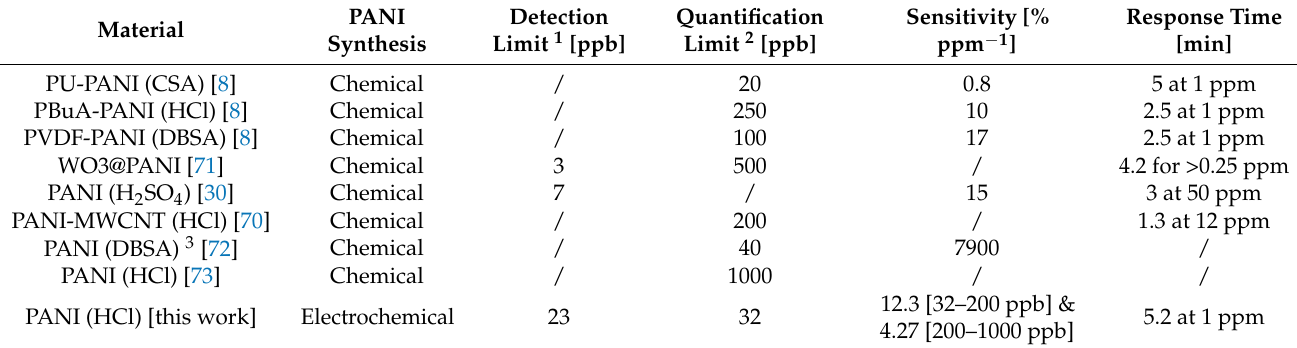
Table 1. Metrological parameters for the NH 3 gas sensors based on PANI at